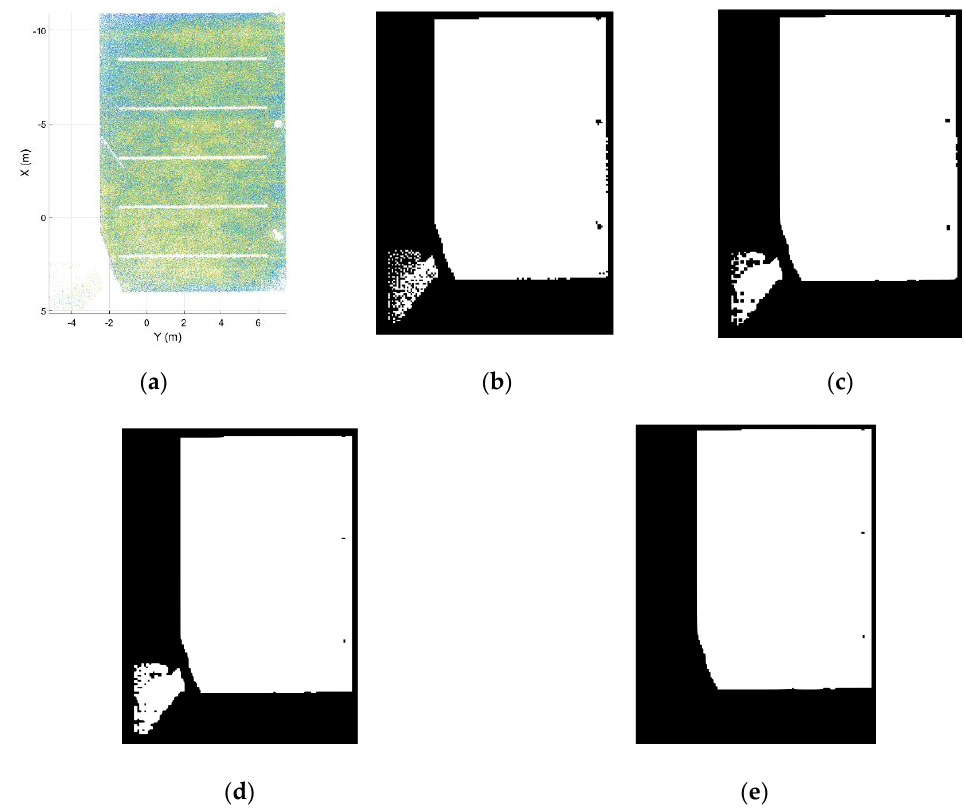
Figure 5. Ceiling delimitation for room segmentation. ( a ) Segmented point cloud of the ceiling. ( b ) Binary image of the ceiling point cloud. ( c ) Binary image after a morphological closing. ( d ) Binary image after a morphological dilatation. ( e ) Binary image of a room delimitation.